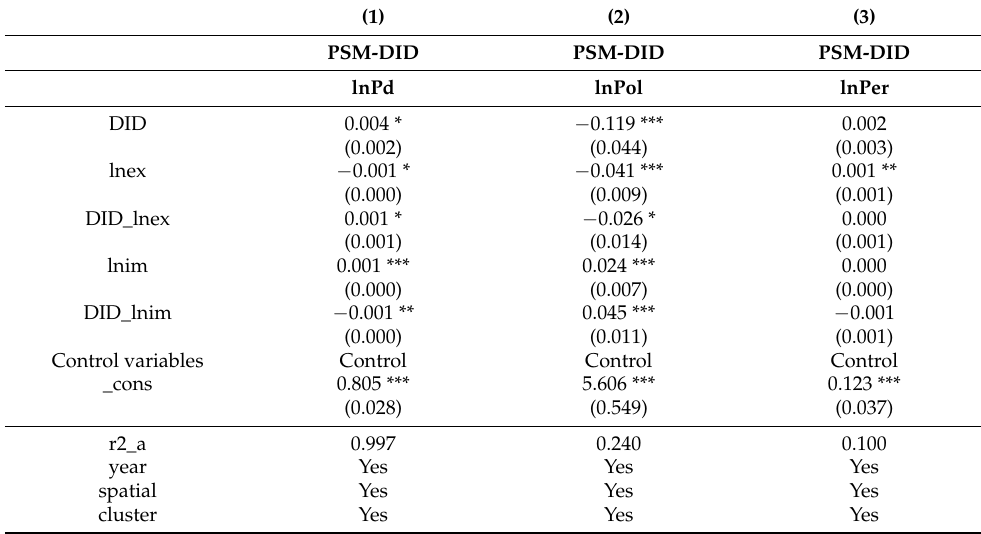
Table 4. Test of influence